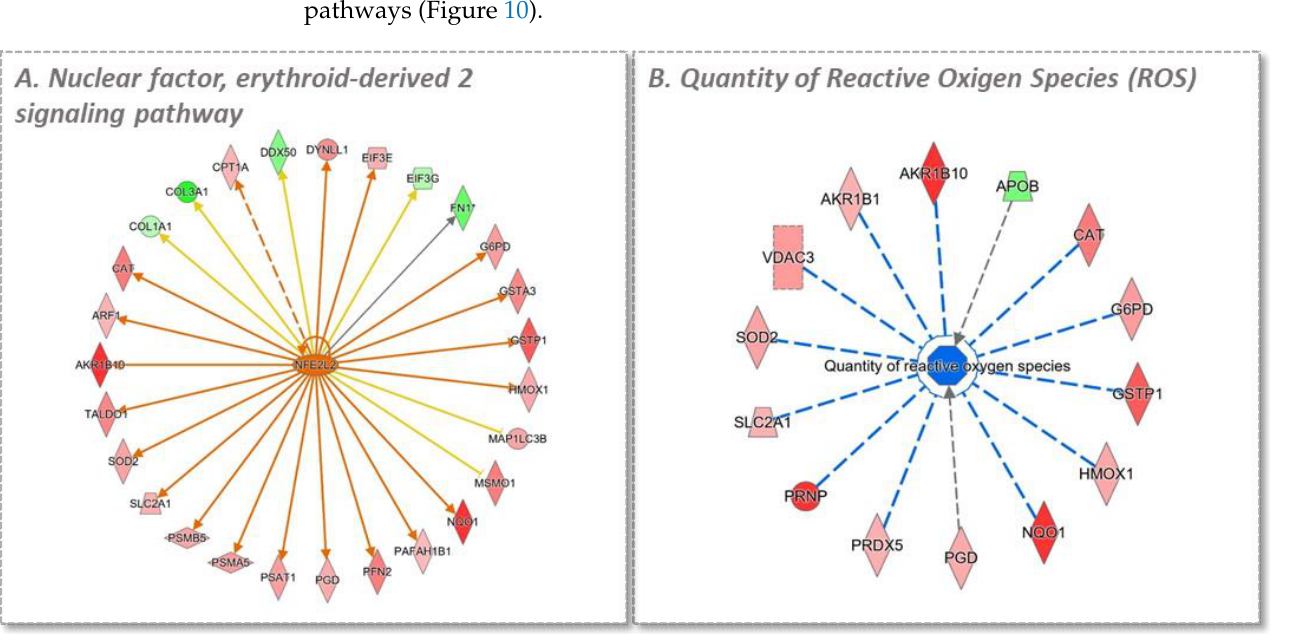
Figure 10. IPA analysis in the CTR-TNF-TAP vs. CTR-TNF condition. ( A ) illustrates the different regulated proteins present in the analysis which correlate with NRF2 activation. ( B ) illustrates the effect that the differentially regulated proteins have on the quantity of reactive oxygen species, confirming a trend of reduction in oxidative stress. The prediction legend (IPA) is reported in Figure